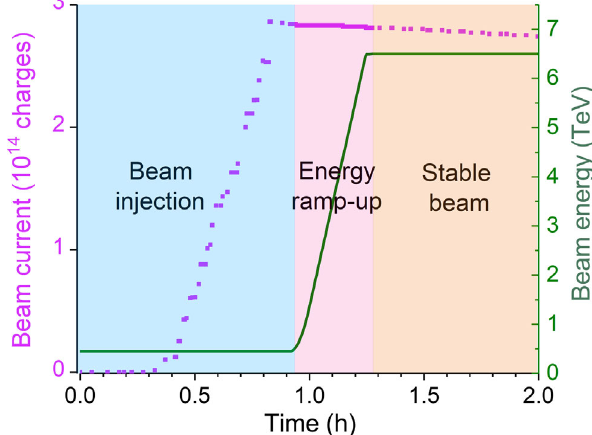
FIG. 1. A standard LHC fill during injection, energy ramp-up and stable beam phase. The beam current (circulating charges) and the beam energy (GeV) are displayed in purple and green,